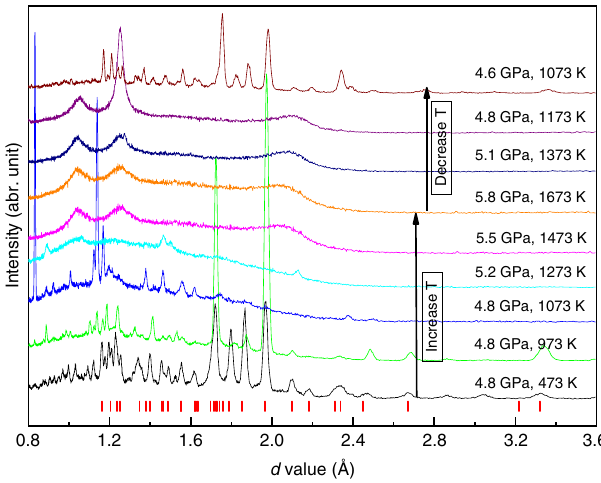
Fig. 3 Energy-dispersive X-ray diffraction patterns of CaCO 3 at high pressure and high temperature. The data were collected at a fi xed 2 θ of 15° and the energy ( E ) in the x axis was transferred to d -value by the equation of Ed sin θ ð Þ ¼ 6 : 199 keV (cid:2) Å. The short red bars denote the peaks